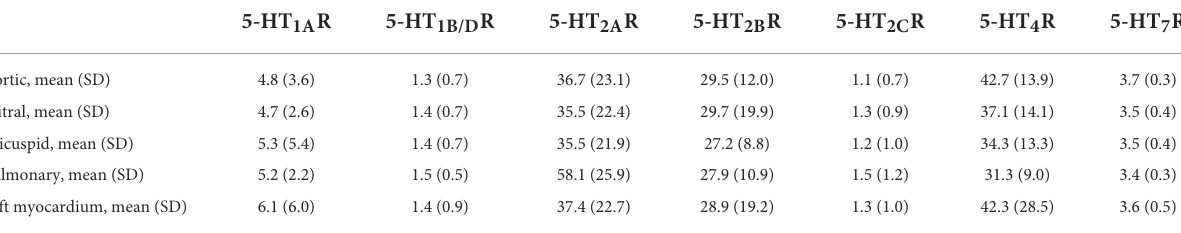
TABLE 1 Quantitative expression of the different 5-HTRs (i.e., 5-HT 1 AR, 5-HT 1B / D R, 5-HT 2A R, 5-HT 2B R, 5-HT 2C R, 5-HT 4 R, 5-HT 7 R) on human valvular cusps (i.e., aortic n = 14, mitral n = 28, tricuspid n = 28 or pulmonary n = 3) or on human left myocardium as a control ( n = 28) (see also Figure